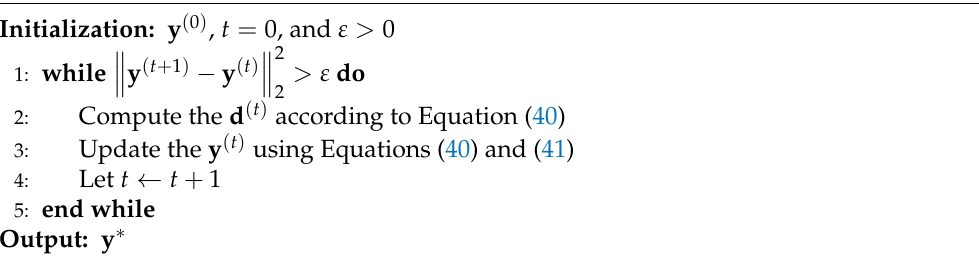
Algorithm 2 Bayes–CG algorithm for solving Equation (35)